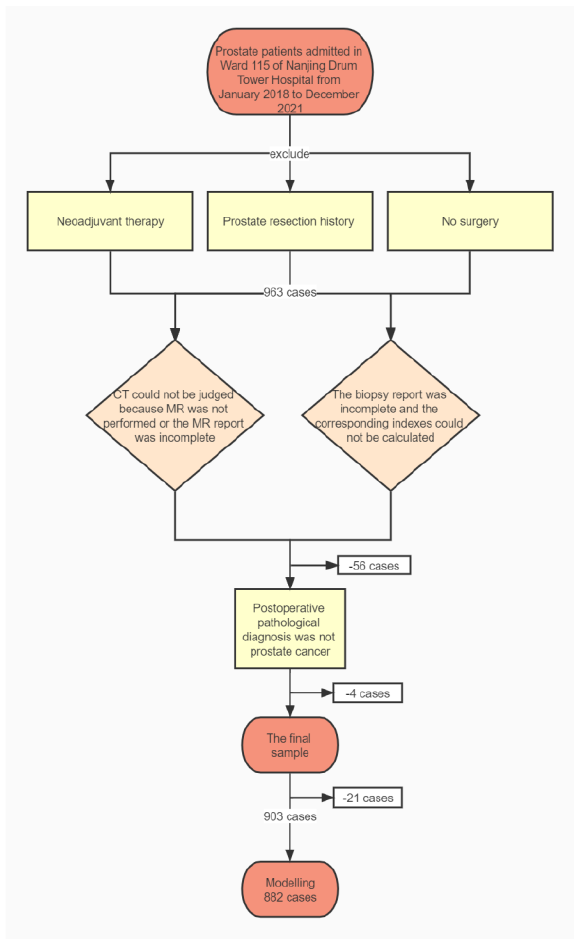
Figure 1. Inclusion and exclusion